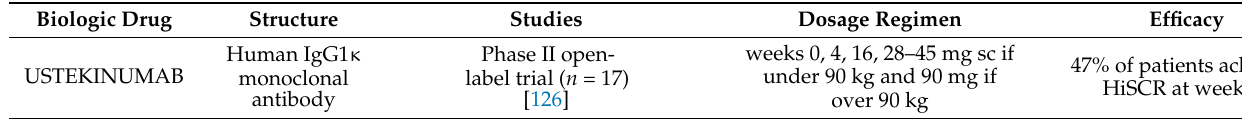
Table 5. Anti-IL-12/23 agents for HS